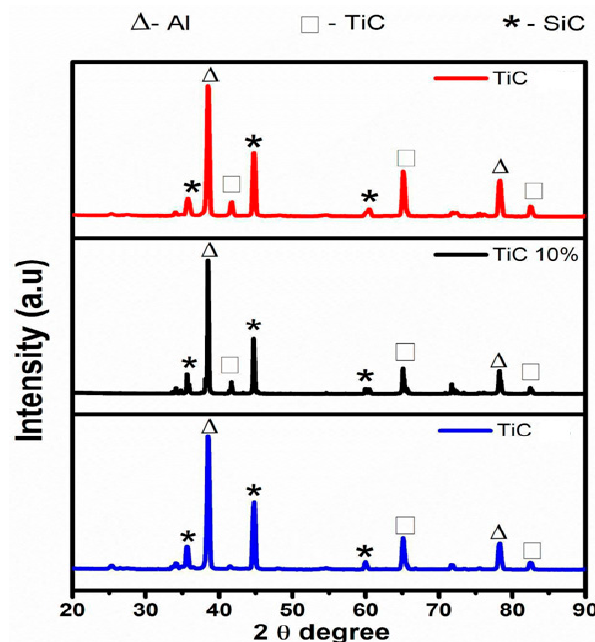
Figure 8. Processed X-ray diffraction of the metal matrix composite structure Al-SiC-TiC.